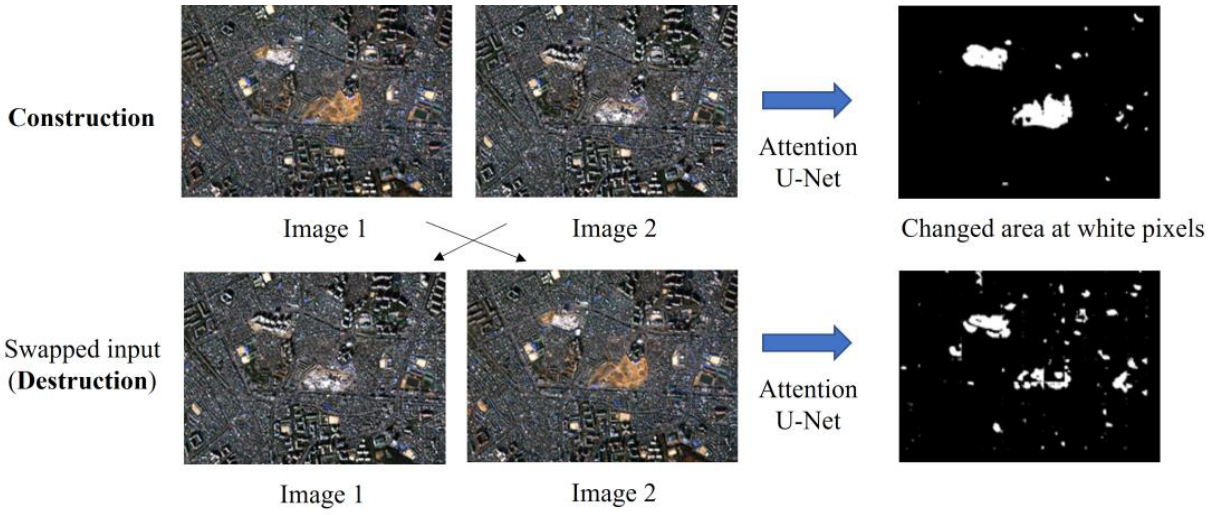
Figure 1. Change detection for reversed image order.